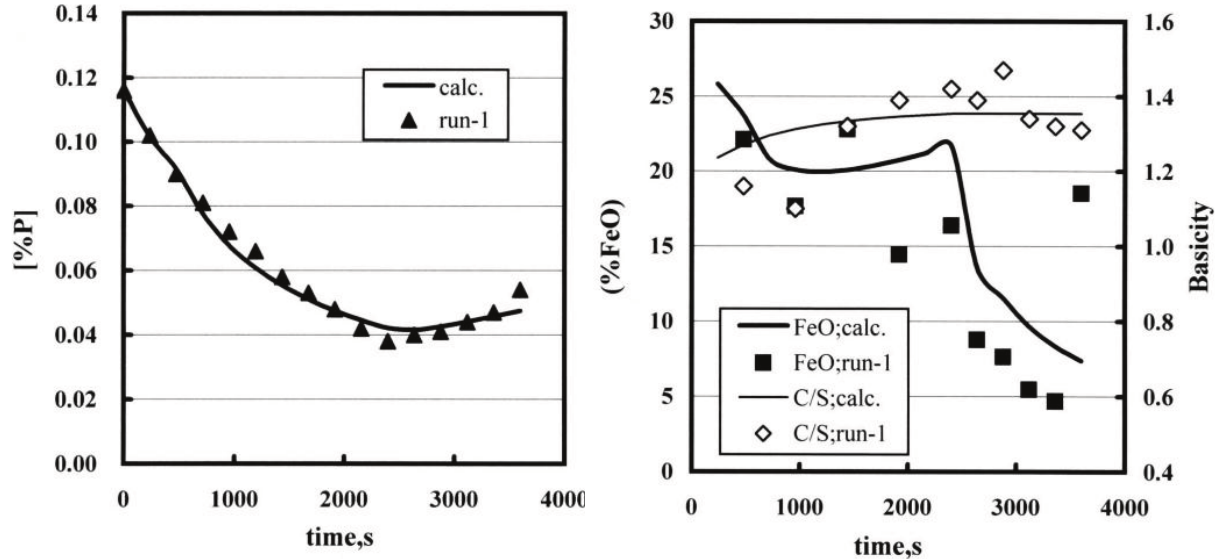
Figure 7. Comparison of the calculation results with the experiment